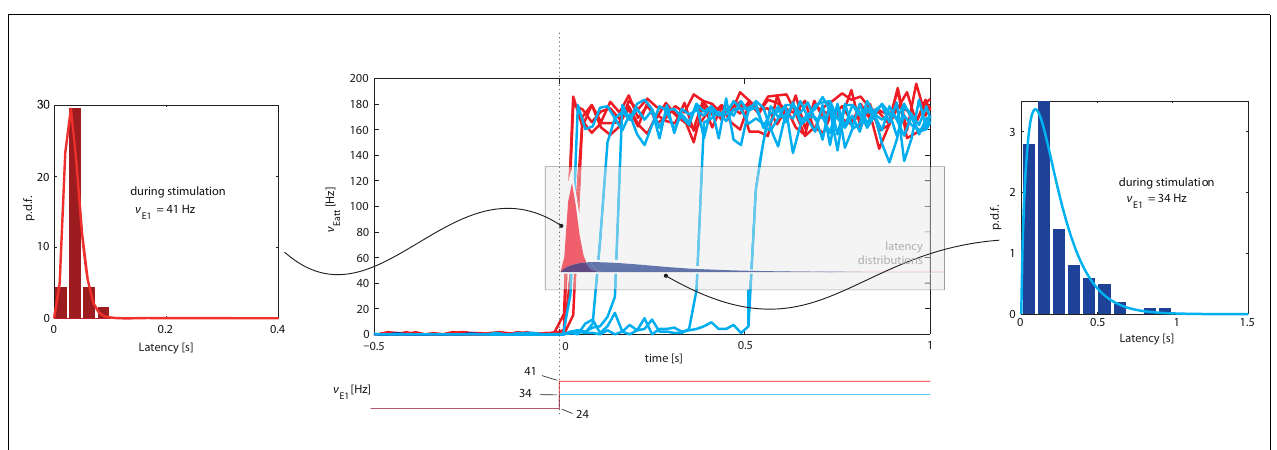
FIGURE 8 | Central Panel : superposition of average E att activity, between the onset of stimulation and the transition time (defined as E att transitioning from the “low” spontaneous state to the “high” stable activity reaching ν = 50Hz). Stronger stimulation results in short, narrowly state induced by stimulation (increase of E1 activity from baseline of distributed latencies, weaker stimulation in long, broadly distributed latencies. ν = 24Hz). Blue tracks correspond to weaker ( ν = 34Hz), red tracks to Note the different time-scales of lateral insets.The same latency distributions E1 E1 are superimposed over the central stronger stimulation ( ν E1 = 41Hz). Lateral panels: distributions of latencies